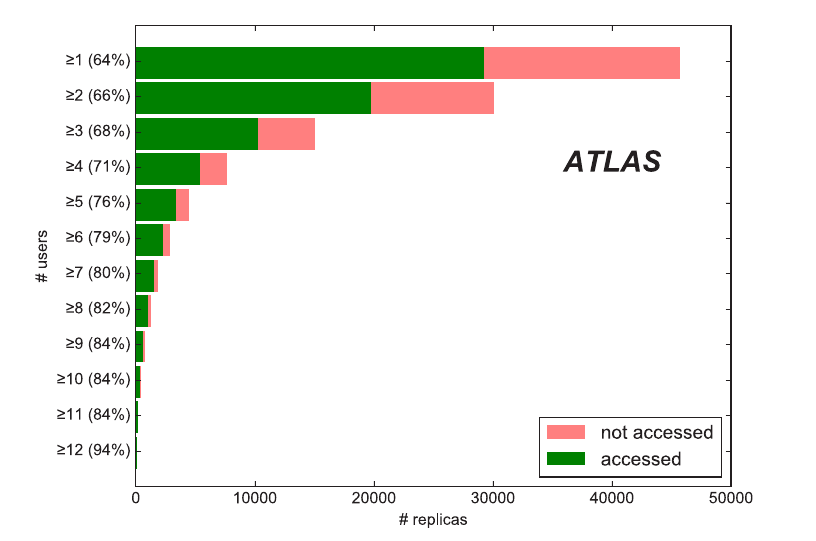
Figure 2. Number of accessed and not accessed replicas that pass selection on lower thresholds on the number of users that are associated with the file access traces of their associated datasets seven days before the replica creation.